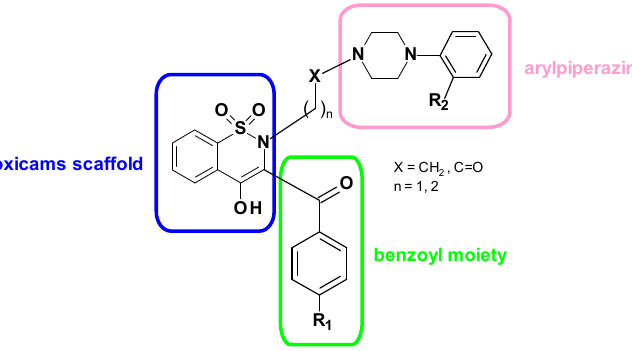
Figure 2. General structure of new oxicam analogues.